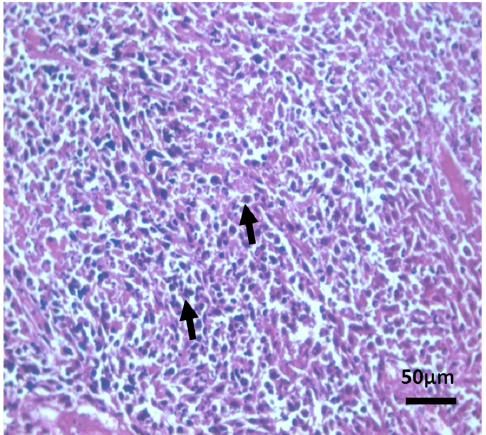
Figure 13. Sections of the positive control group showed malignant growth formed of sheets of malignant epithelial cells with large nuclei with an increased nucleocytoplasmic ratio ( black arrow ), showing a moderate degree of anaplasia (HE, ×400).